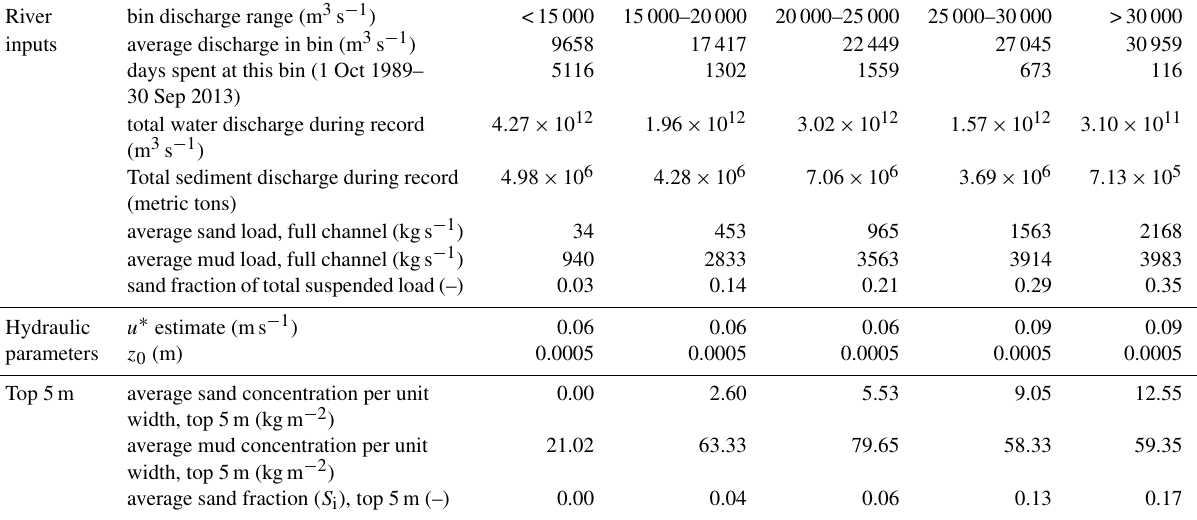
Table 2. Data used to calculate S i . The sand and mud concentrations for each bin are weighted with the respective total water discharge to provide a yearly average sand fraction input to the splay of